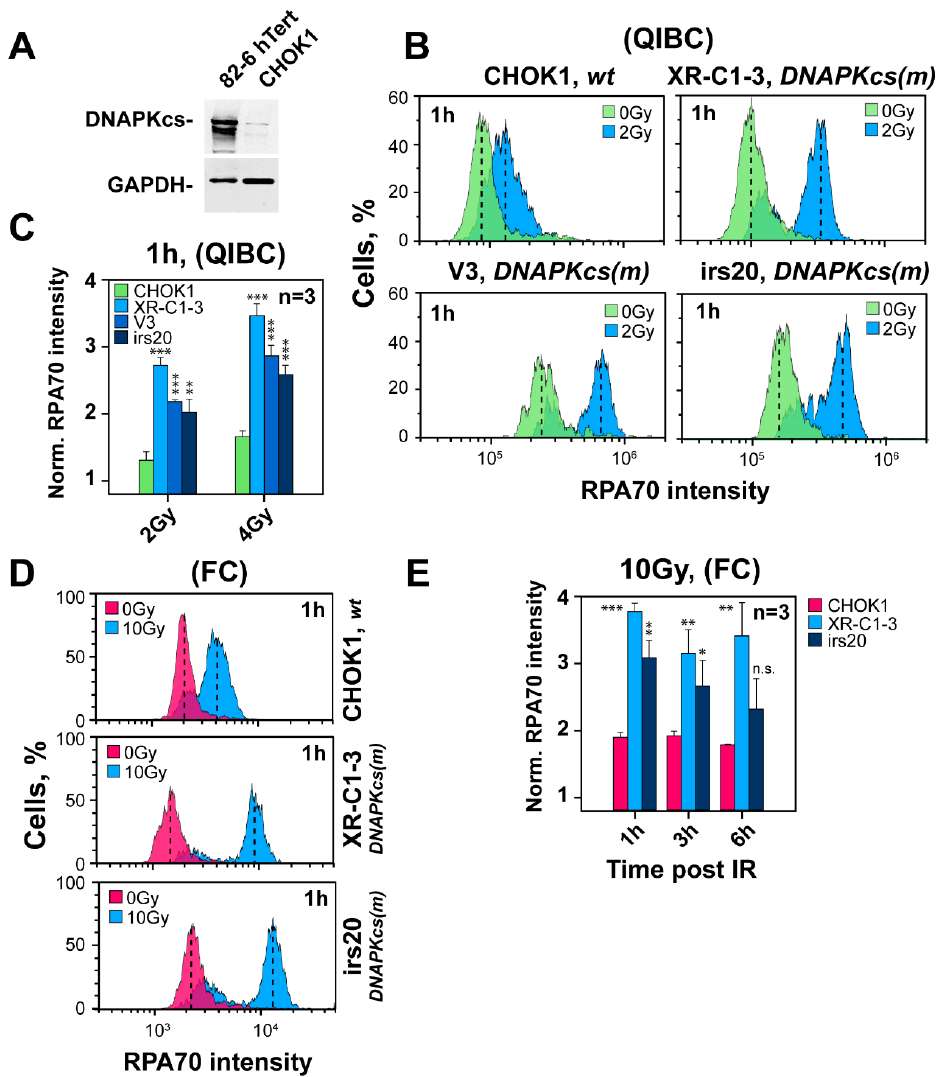
Figure 2. DNA-PKcs deficient CHO mutants uniformly show increased resection in G 2 -phase. ( A ) Western blot of DNA-PKcs in human 82-6 hTert and hamster CHOK1 cells. ( B ) As in Figure 1B for CHOK1 ( wt ) and the DNA-PKcs mutants, XR-C1-3, V3 and irs20. ( C ) As in Figure 1C for the mutants in panel ( B ). ( D ) As in Figure 1D for the mutants in panel ( B ). ( E ) As in panel ( C ) for data obtained using FC with the same mutants. * indicates p < 0.05, ** indicates p < 0.01, and *** indicates p < 0.001, while n.s. indicates